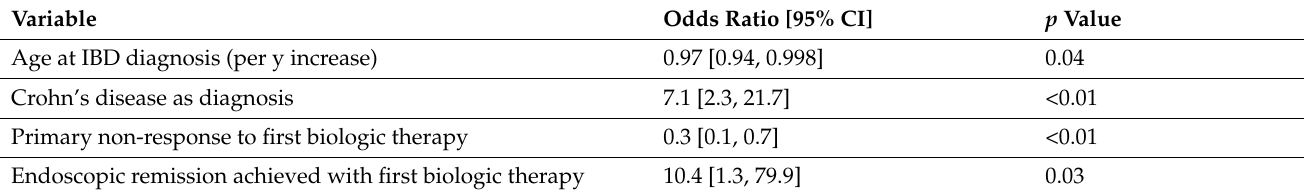
Table 3. Cox regression analysis (final model) depicting factors associated with increased likelihood of treatment persistence over time during the study follow-up